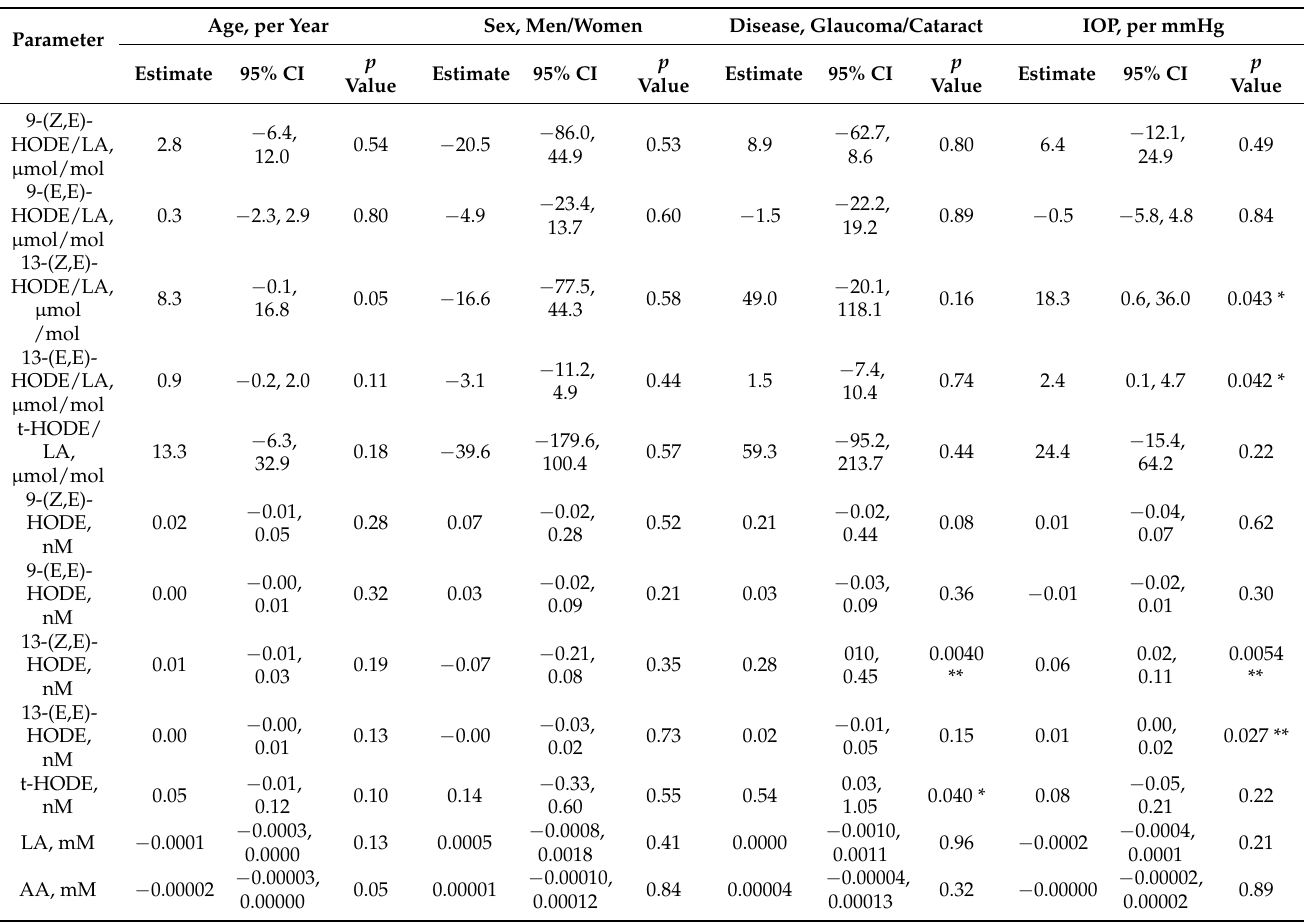
Table 5. Possible association between HODE levels and background parameters by multivari- ate